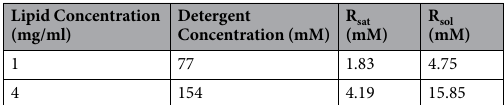
Table 1. Highlights of lipid/detergent concentrations, saturation (R sat ) and solubilization (R sol ) concentrations from TX-100 induced DPhPG